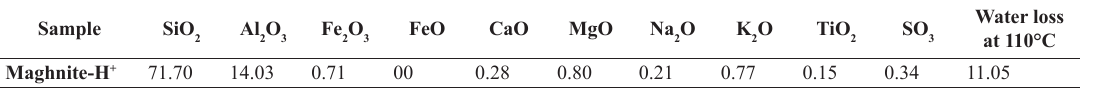
Table 1. Composition (in %) of Maghnite by X-Ray Fluorescence (XRF) analysis.